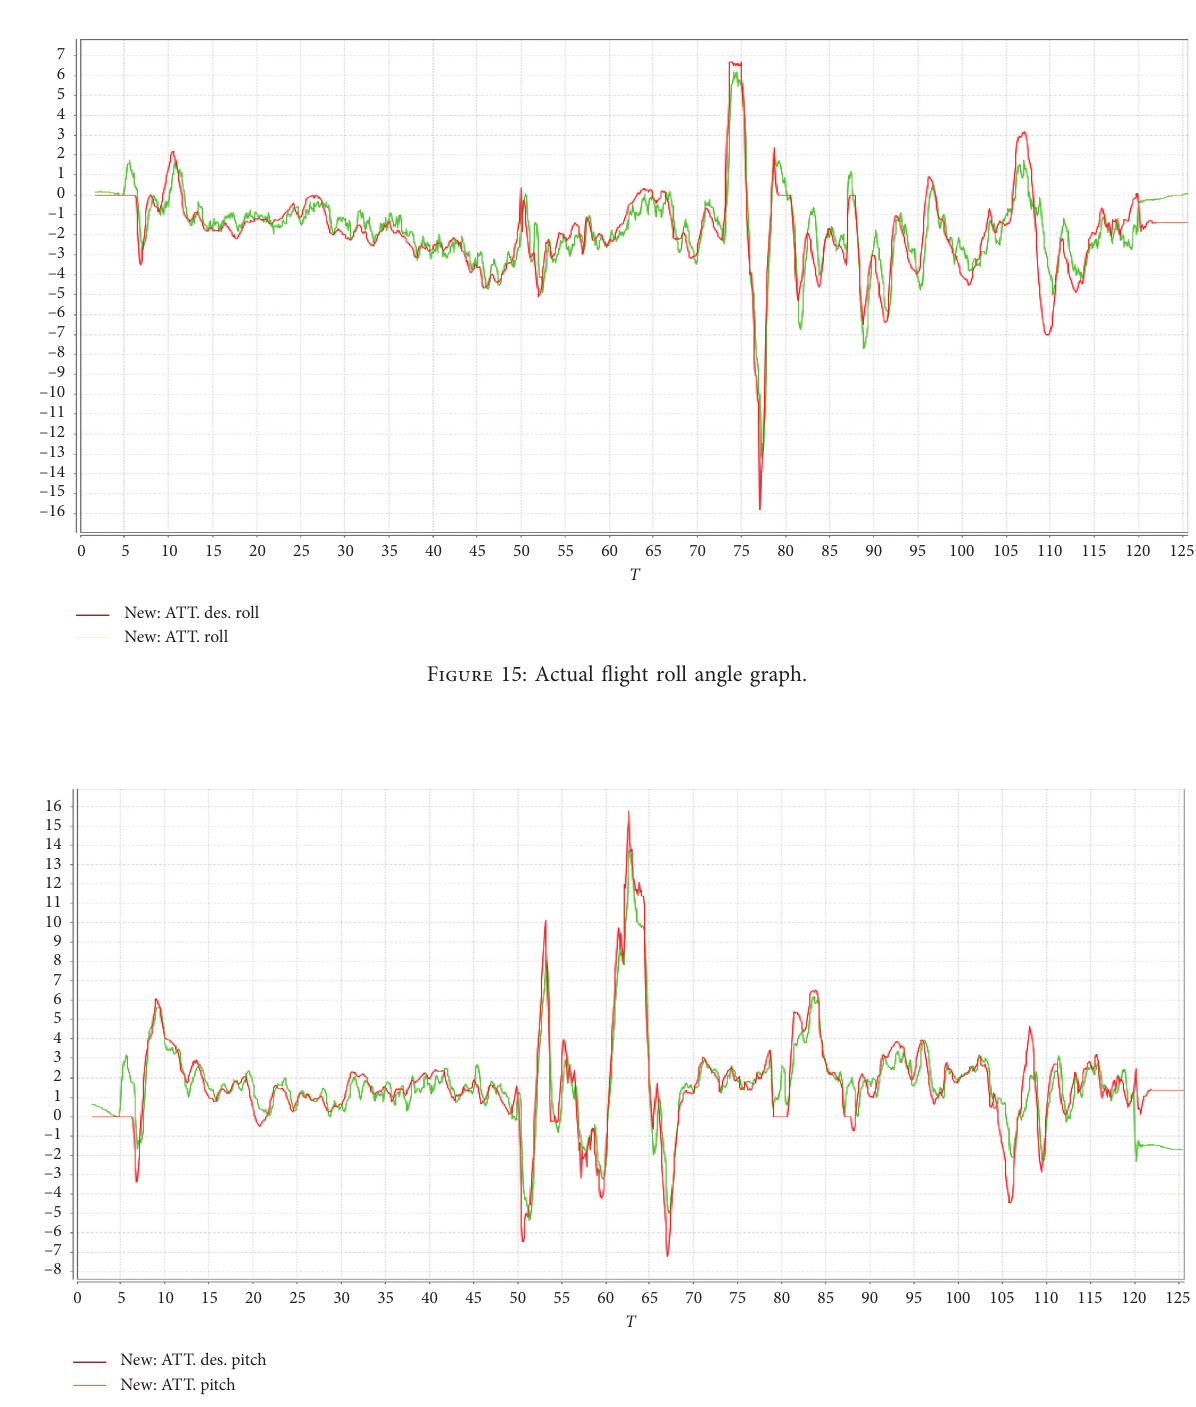
Figure 16: Actual flight pitch angle